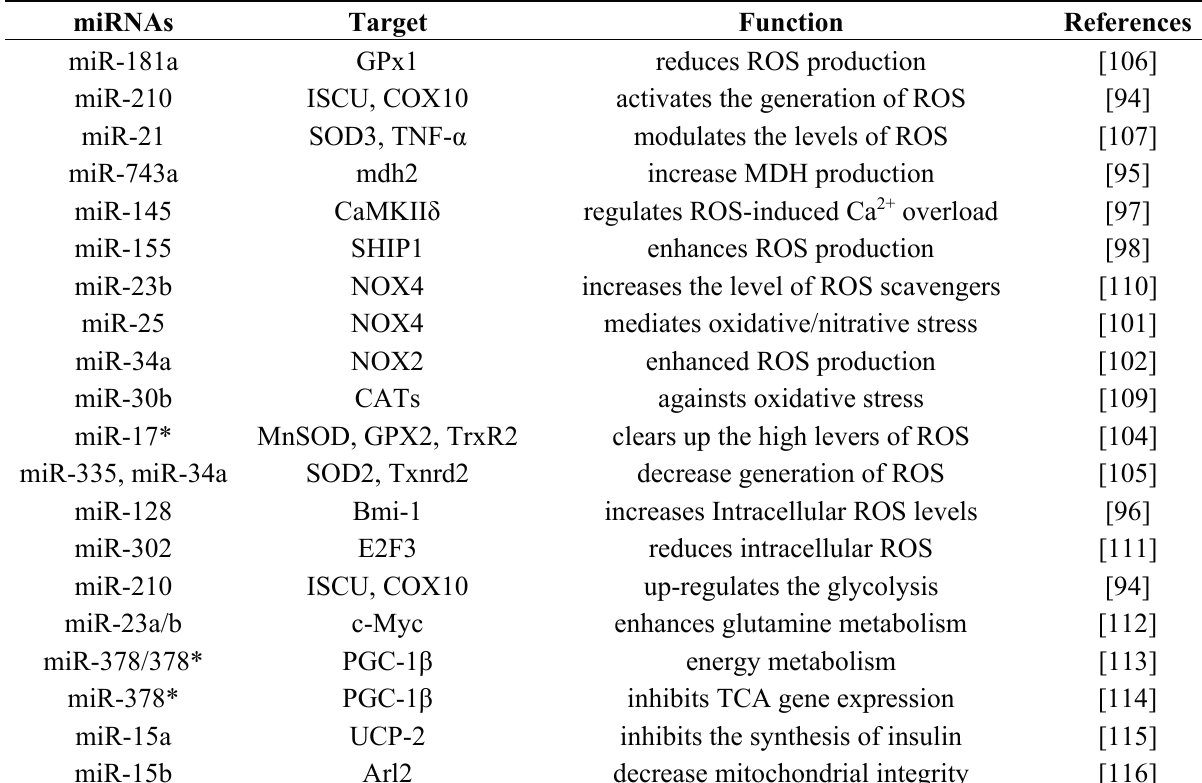
Table 1. miRNAs associated with mitochondrial oxidative stress, energy metabolism and